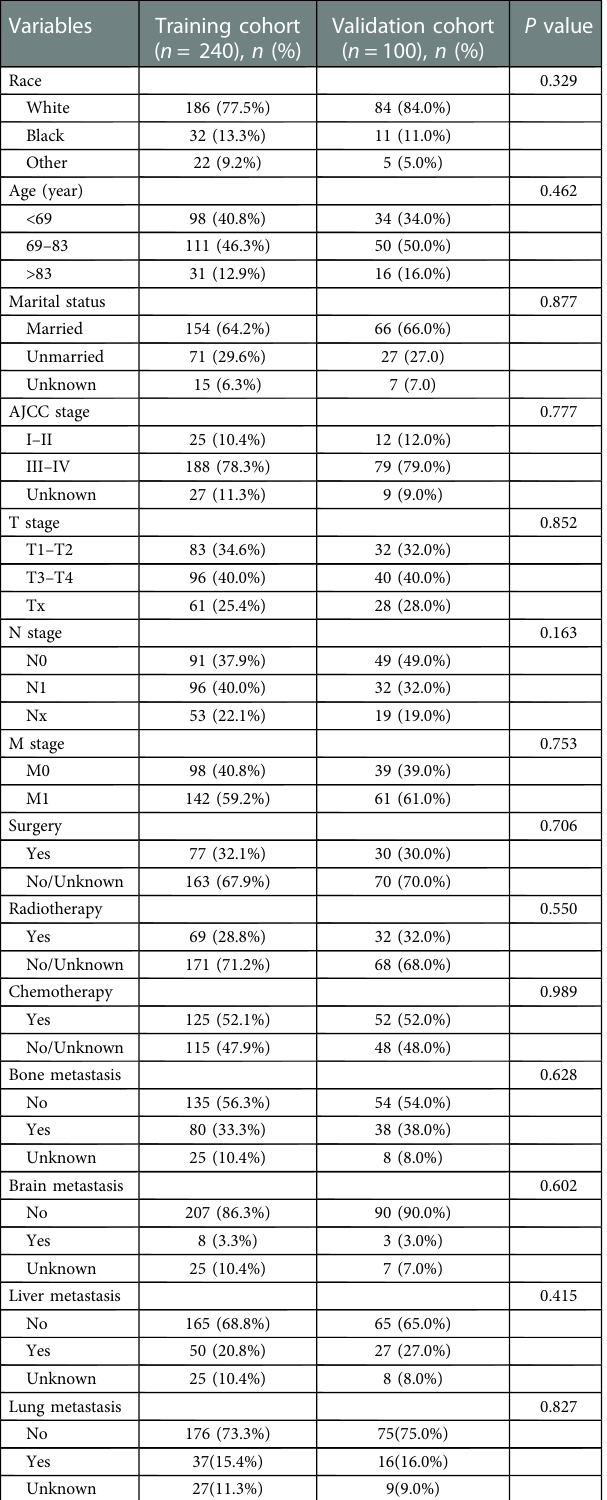
TABLE 1 The clinicopathological features of the patients in training cohort and validation